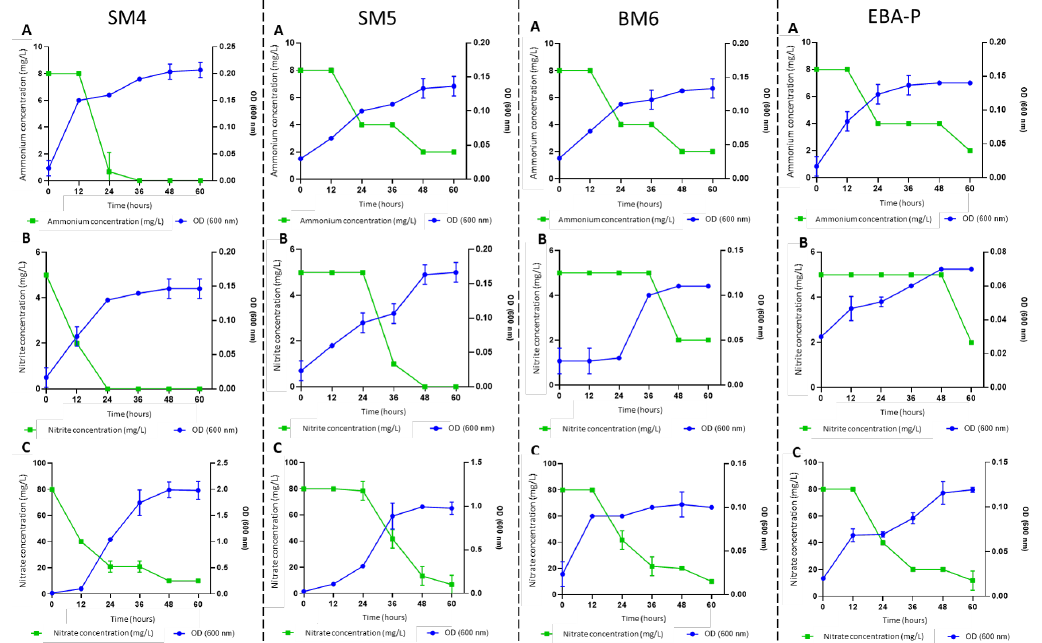
+ -N), B) 4 , in aerobic nm